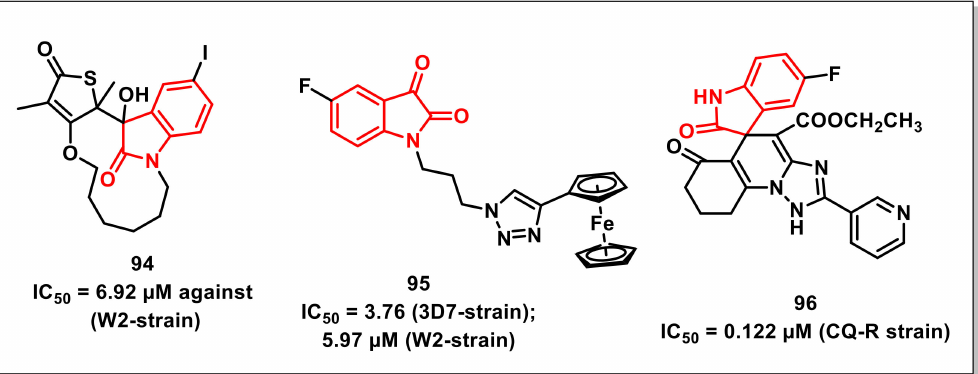
Figure 16. Miscellaneous examples of Isatin-based compounds as